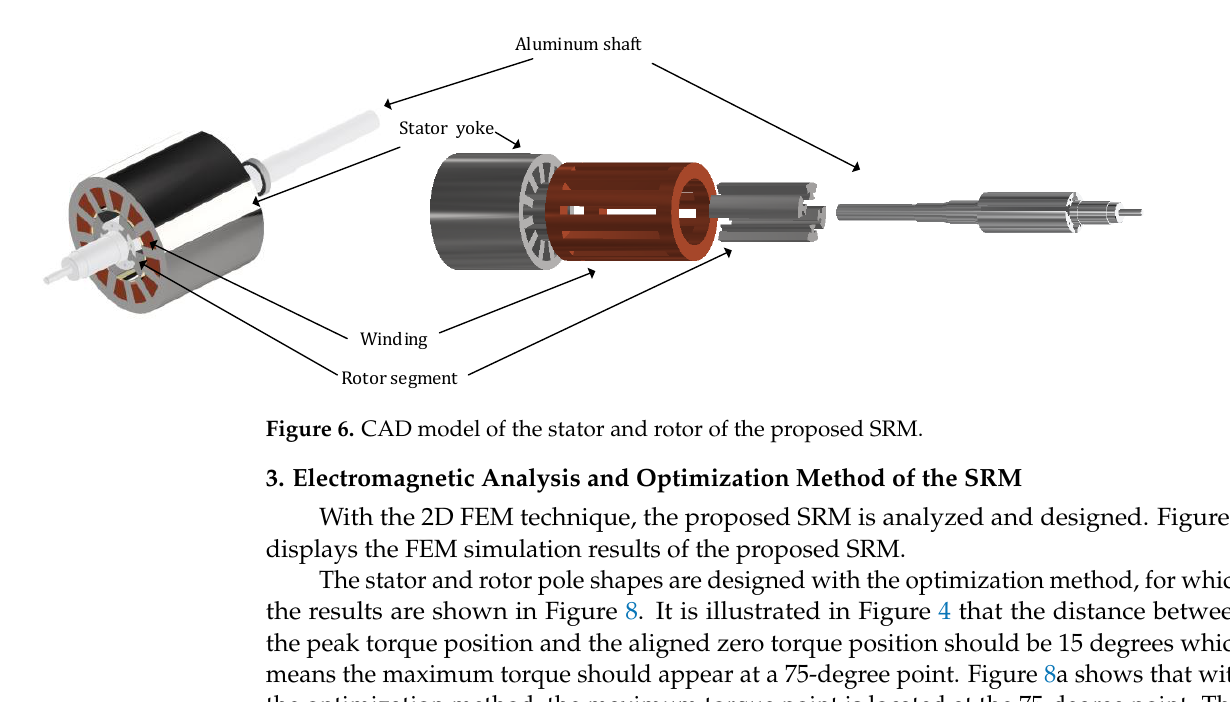
Figure 5. Magnetic fields of the proposed SRM: ( a ) magnetic fields when the previous phase of phase A is aligned; ( b ) magnetic fields when phase A is aligned.